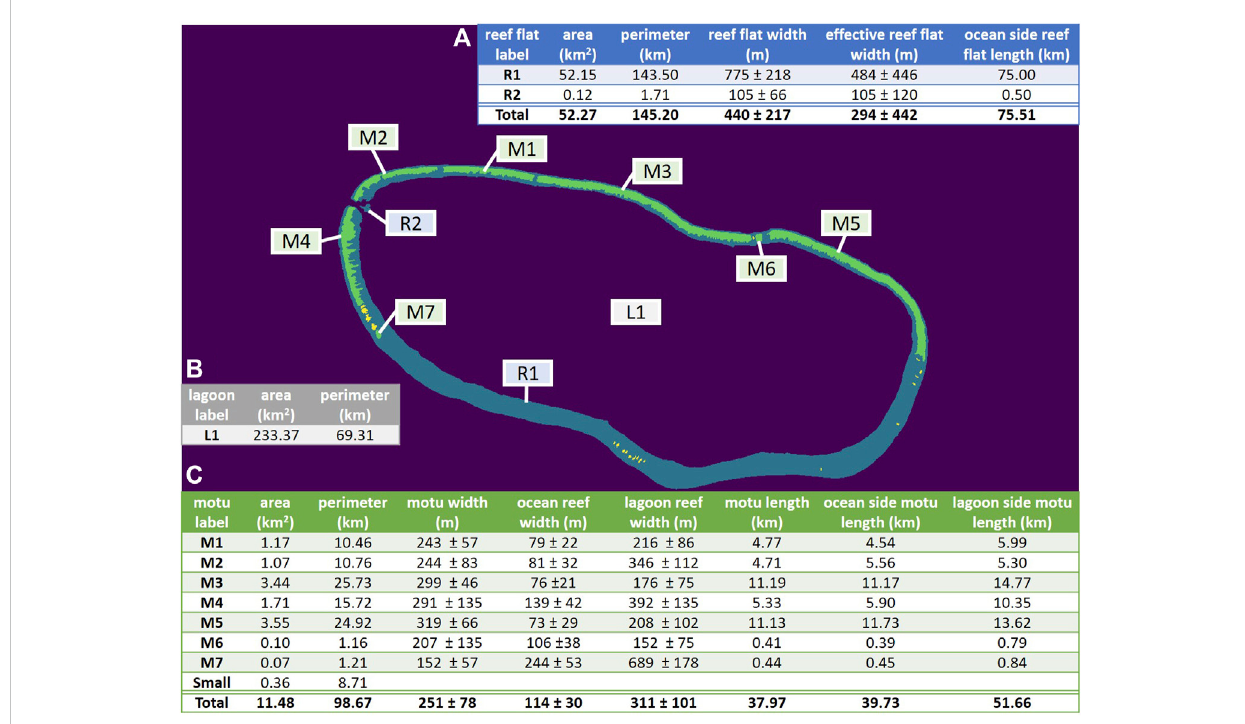
FIGURE 3 Faaite atoll, French Polynesia object level data. Background image is K-means classi fi ed with individual objects labeled: motu are green (all morphometricscalculated)andyellow(smallmotu,onlybasicmorphometricscalculated),reef fl atareblue,andwaterispurple.Motuarelabeledstarting with M, reef fl ats with R, and the lagoon with L. This letter is followed by the index number assigned north to south for each class of object based on the northern most point of that object. Morphometric summarytablesare included for (A) reef fl ats, (B) lagoons, and (C) motu. Error inthe mean widths is one standard